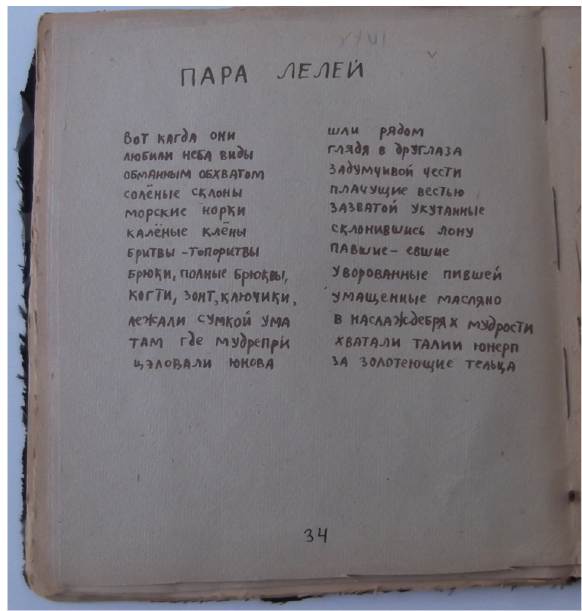
Figure 4. ‘Shedevrez’, p. 34.